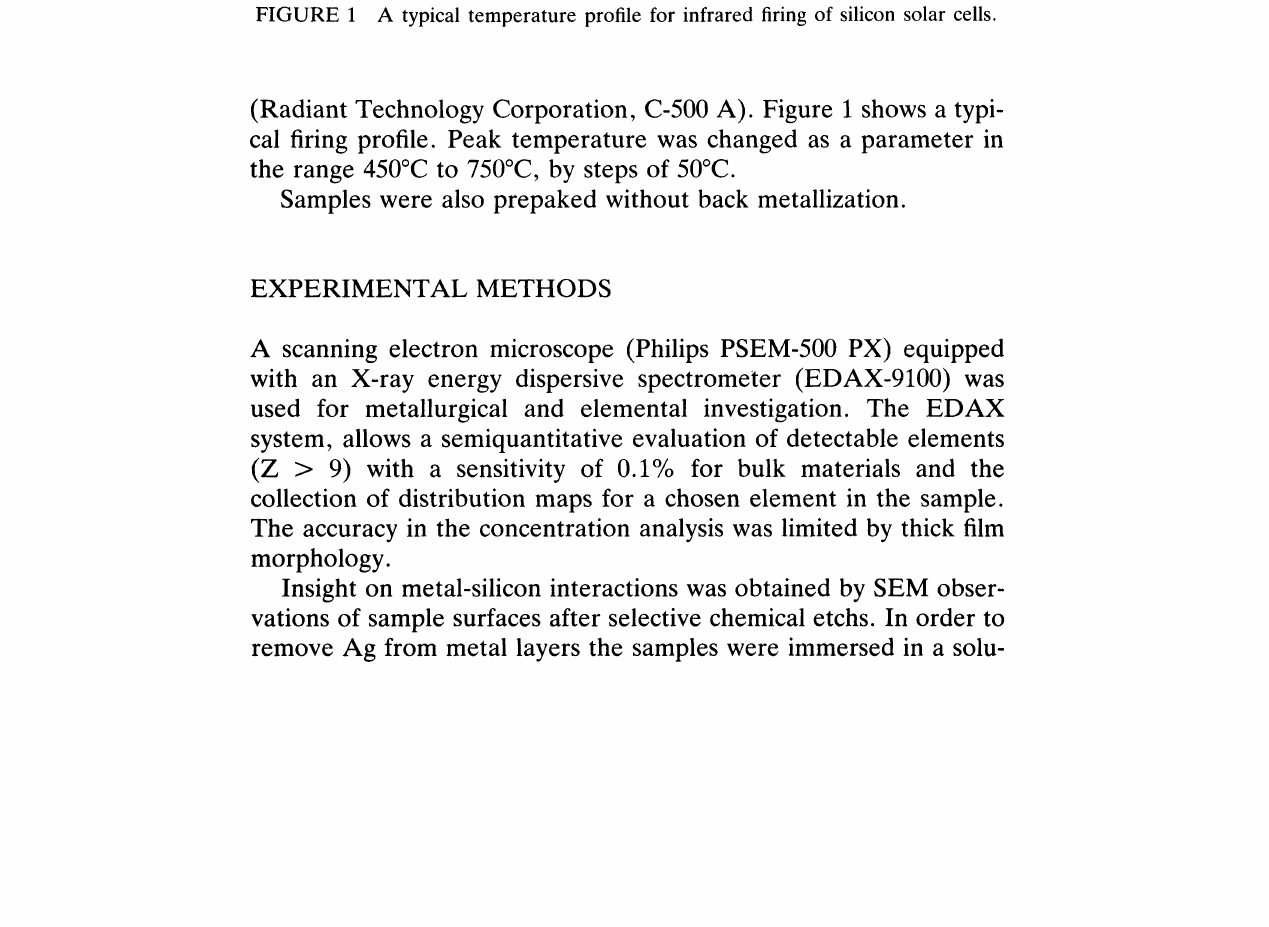
(Radiant Technology Corporation, C-500 A). Figure 1 shows a